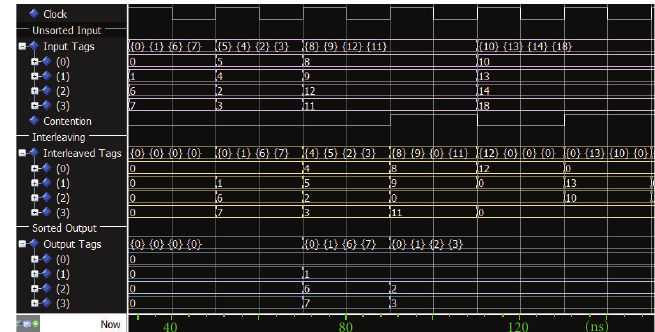
Figure 9: Simulation for interleaved linear sorter, including contention.